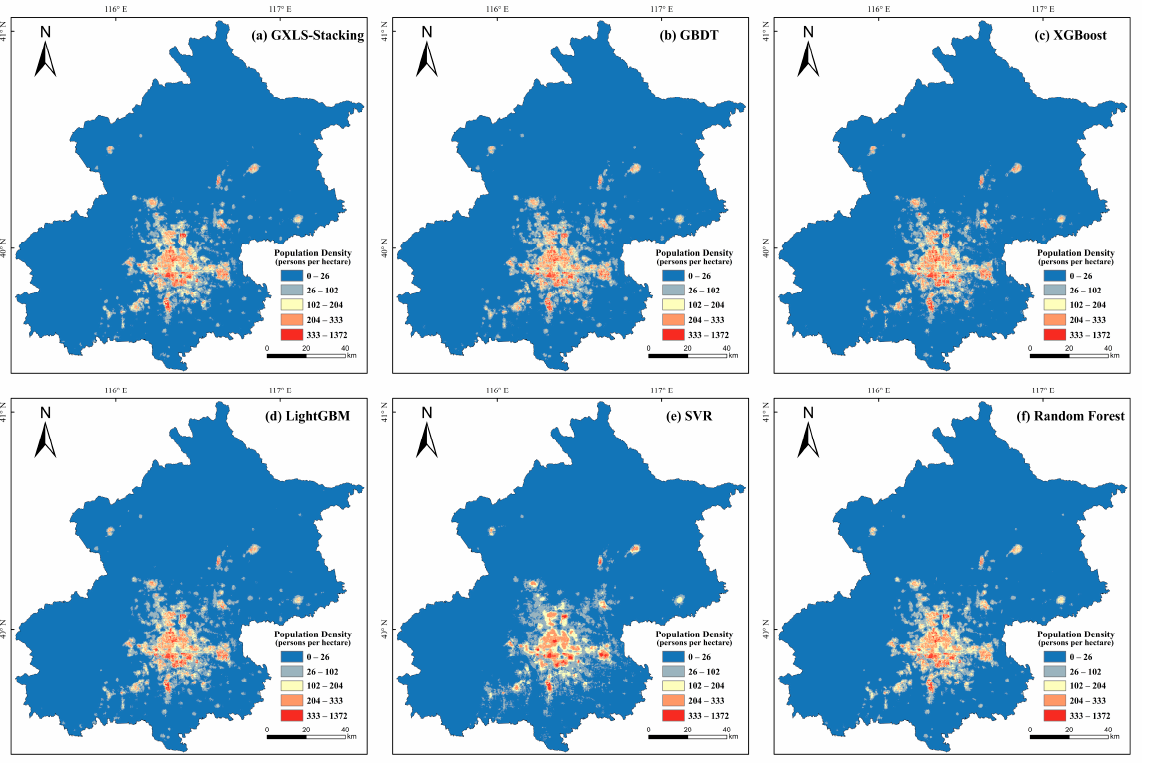
Figure 6. The 100 m spatial resolution dasymetric population density maps for Beijing in 2020 generated by the optimal